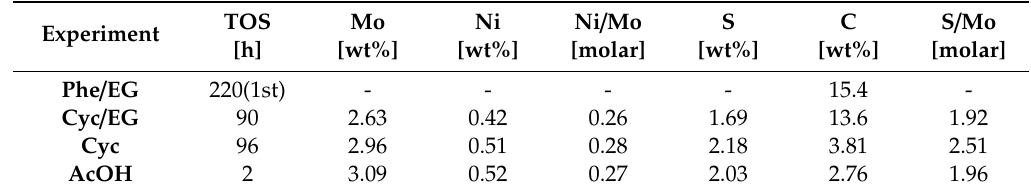
Table 5. Composition of spent catalysts.